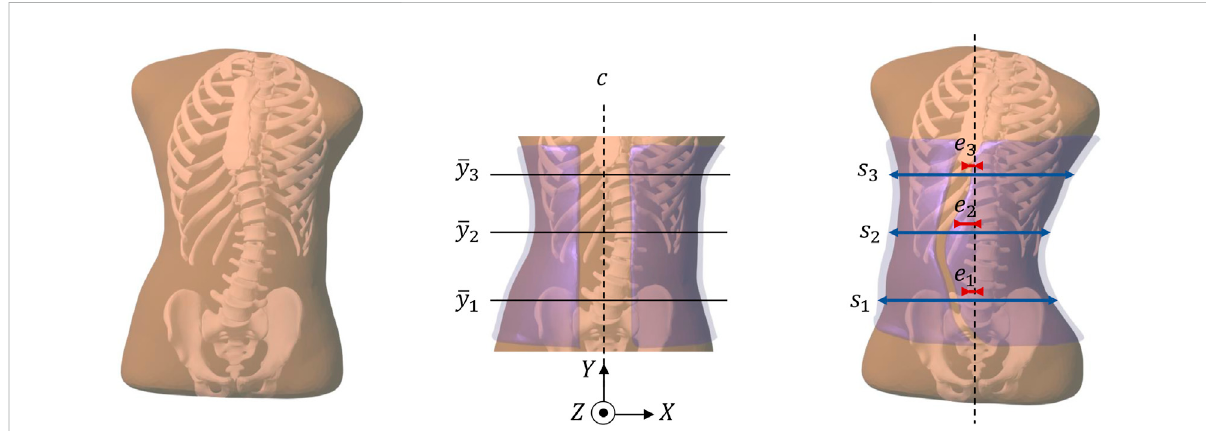
FIGURE 1 This fi gure summarizes the pipeline of our computational brace design methodology. From left to right: (i) Starting from radiographs of a patient, we obtain a personalized simulation model of the trunk (including the spine, the rib cage, and the surrounding soft tissue). (ii) We initialize a brace geometry (in semi-transparent purple) by trimming and slightly offsetting the patient´s skin. In this initial brace geometry, we identify the frontal center line c , andthree heights (cid:1) y 1 , (cid:1) y 2 , (cid:1) y 3 where we focusthecontact forcesbetweenbrace and trunk.(iii)Weautomatically optimize the eccentricity e and horizontal scale s at the three heights. As a result, the brace deforms the full trunk, and produces a correction of the spine